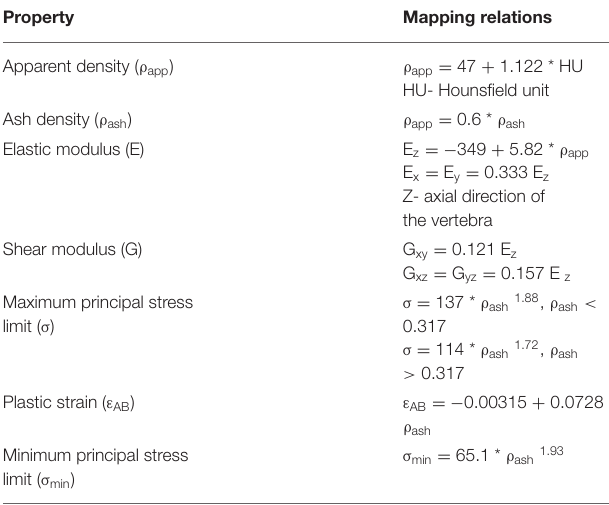
TABLE 1 | Vertebral bone material (density - HU - modulus) mapping relations used in the current finite element study (18, 40–42).